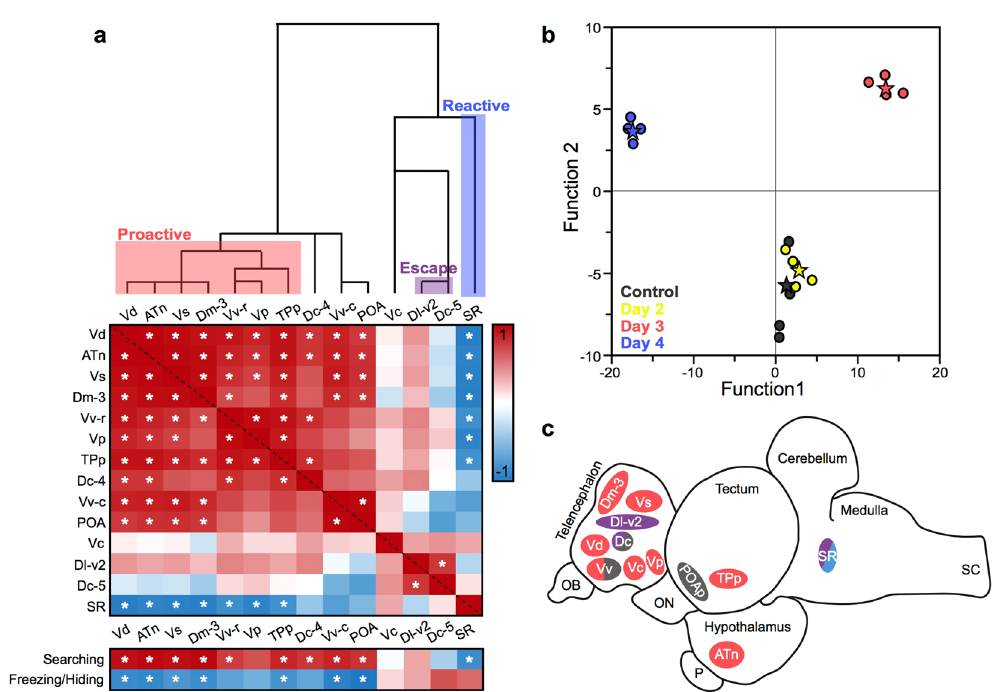
Figure 6. Fish displaying proactive and reactive coping behaviours have distinct patterns of neural activation. ( a ) Hierarchical clustering was used to group brain regions, and Pearson correlation coefficients were used to create a heatmap of neural co-activation across all regions examined, along with searching and freezing behaviours. R-values are represented by colour with red being positive correlations and blue representing negative correlations. Significant correlations ( P < 0.05) are signified with an * . Boxes designating “proactive”, “reactive”, and “escape” are based on neural activation data in Figs 4 and 5. ( b ) Discriminant function analysis of pS6-staining in all brain regions clearly separates fish displaying proactive and reactive coping behaviours from neutral and control fish, indicating distinct neural activation patterns associated with these opposing coping behaviours. Each animal is represented by a circle and group means by a star. ( c ) Schematic summarizing neural activation results in all regions. Nuclei locations and sizes are approximate. Red represents regions associated with proactive, while blue signifies reactive coping behaviours. Purple represents regions that were different in escaping and non-escaping fish, likely relating to spatial learning. See text for